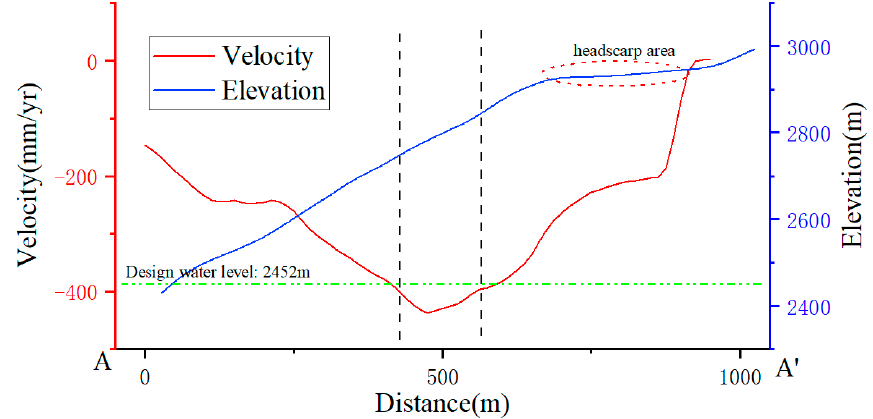
Figure 7. Profiles of deformation rate and elevation. Figure 7. Pro fi les of deformation rate and elevation. Figure 7. Pro fi les of deformation rate and elevation.